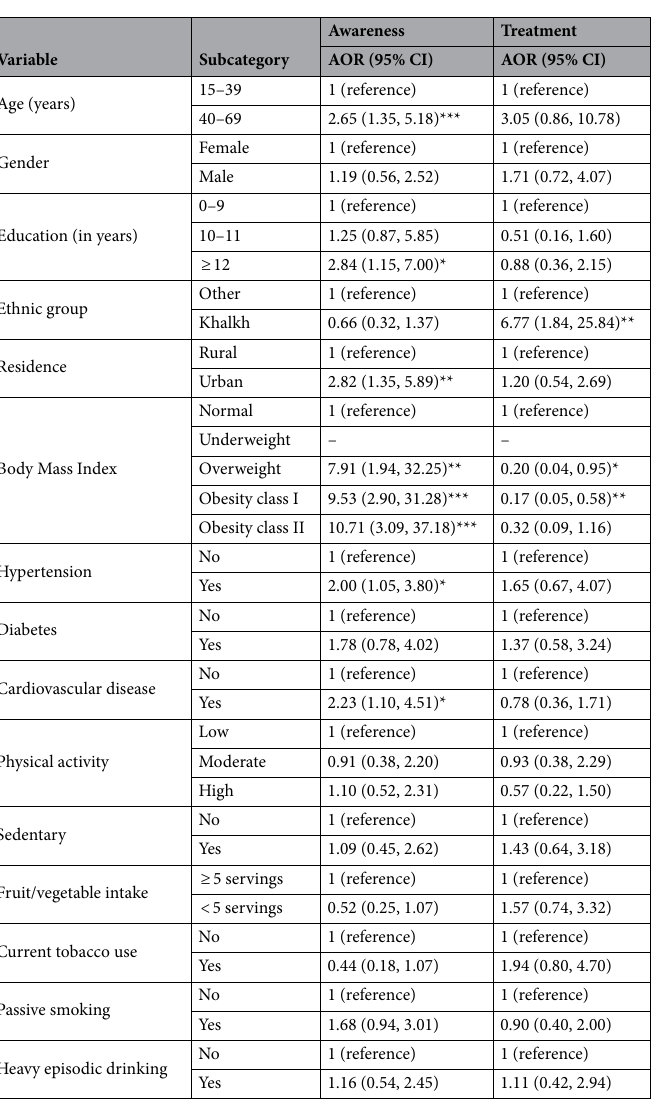
Table 5. Associations with prevalence of dyslipidaemia awareness and treatment. AOR adjusted odds ratio. *** p < 0.001; ** p < 0.01; * p <